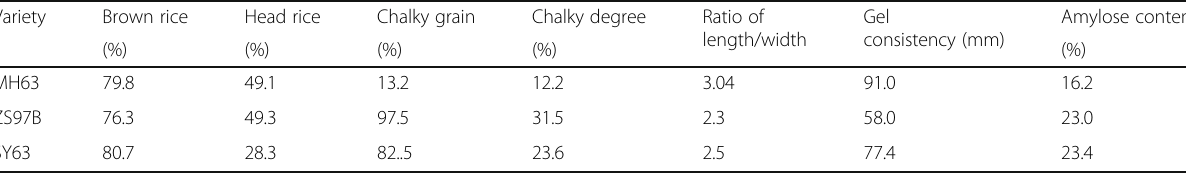
Table 1 Grain quality of SY63 and its parents Variety Brown rice Head rice Chalky grain Chalky degree